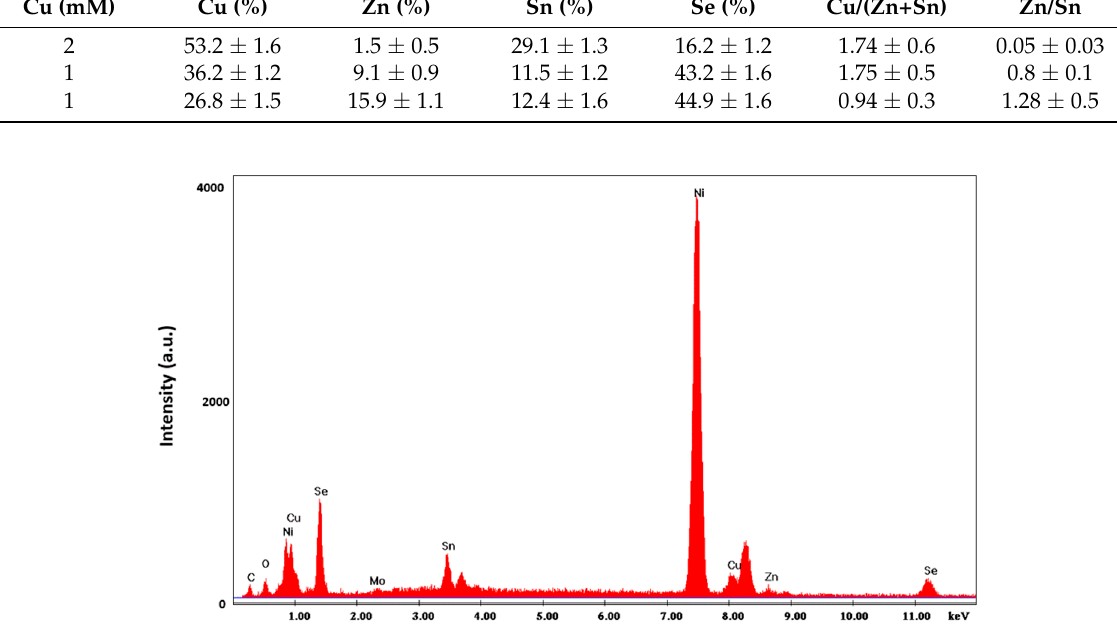
Figure 3. EDS spectrum of the optimized CZTSe nanostructured electrode. NWs were obtained at pH = 3 with a copper content of 1 mM.